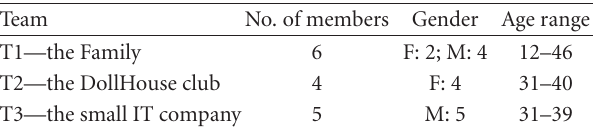
Table 2: Participating groups (F = female, M =